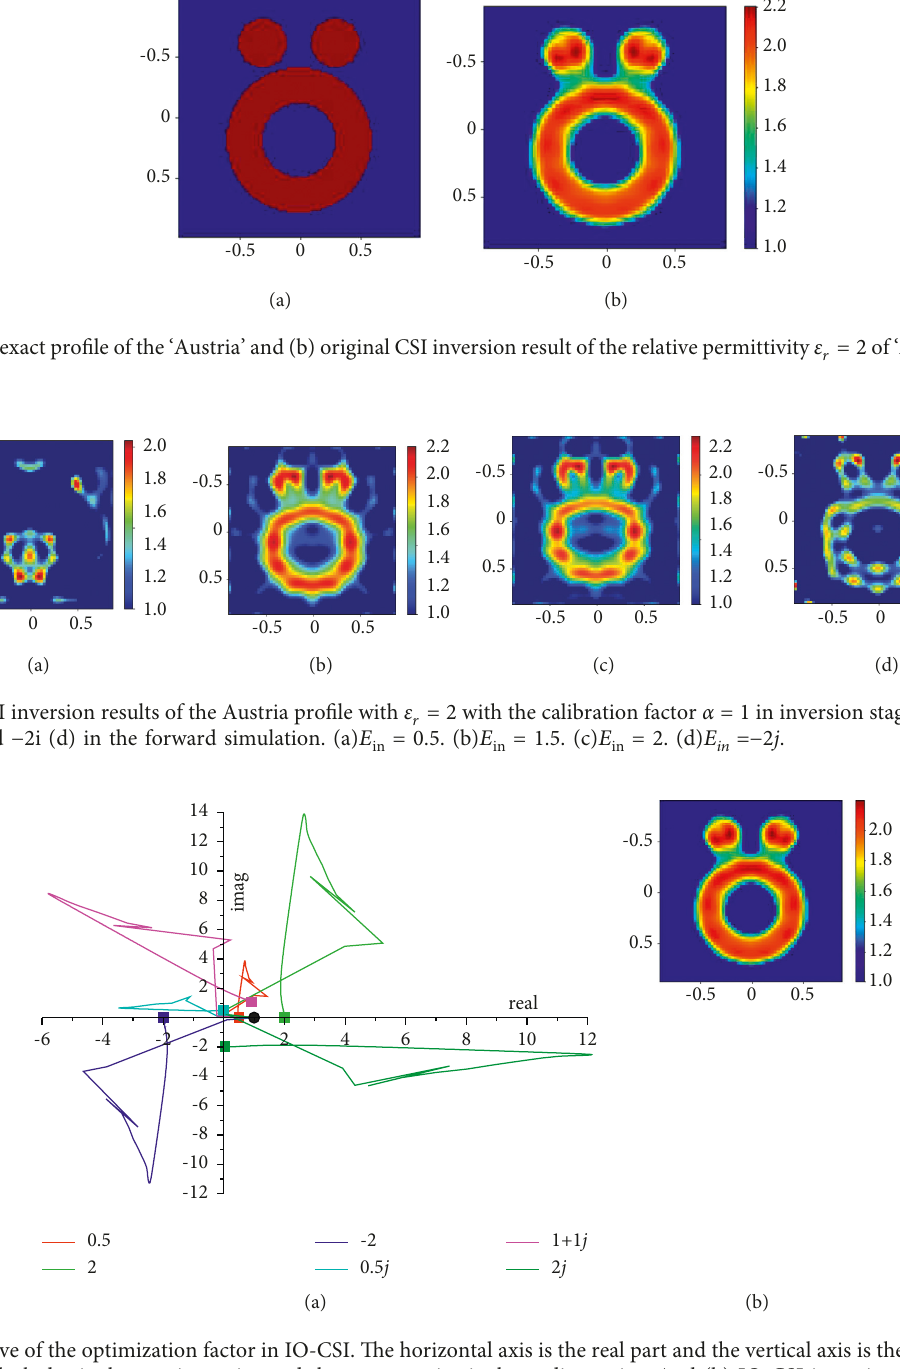
Figure 4: (a) Curve of the optimization factor in IO-CSI. The horizontal axis is the real part and the vertical axis is the imaginary part. For each curve, the black dot is the starting point and the square point is the ending point. And (b) IO-CSI inversion result.